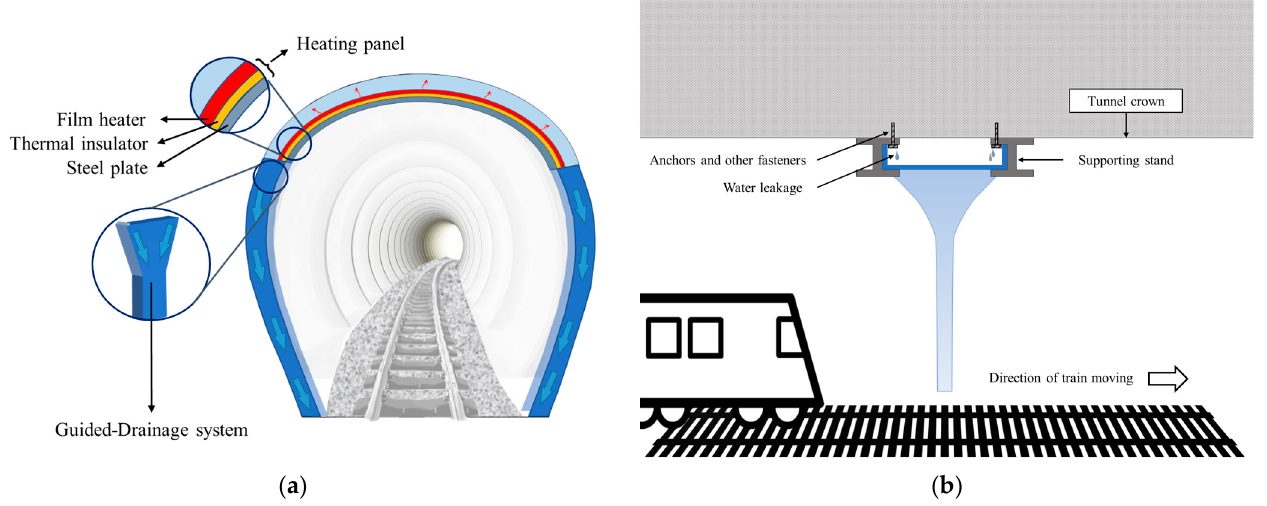
Figure 3. The conceptual design of the thawing-guided drainage system ( a ) and a cross-sectional diagram of the supporting stand ( b ).